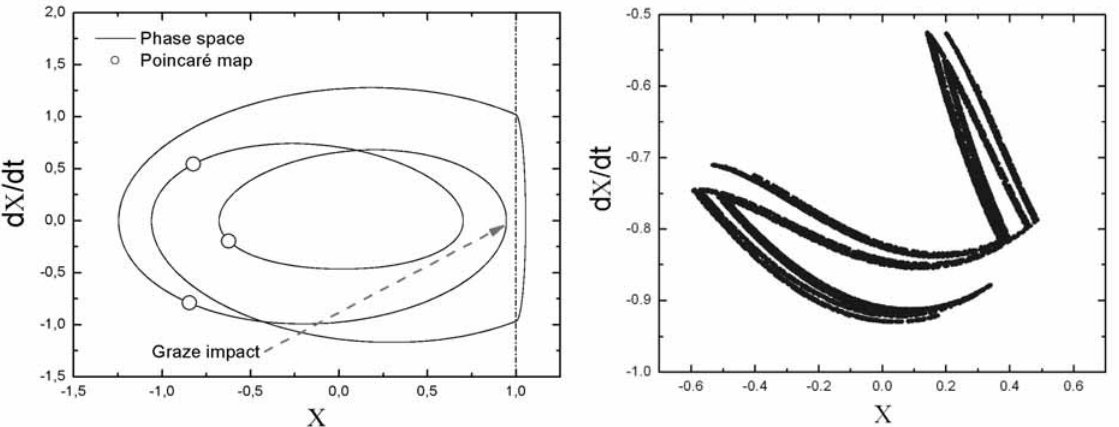
Fig. 10. Responses near the grazing orbit.